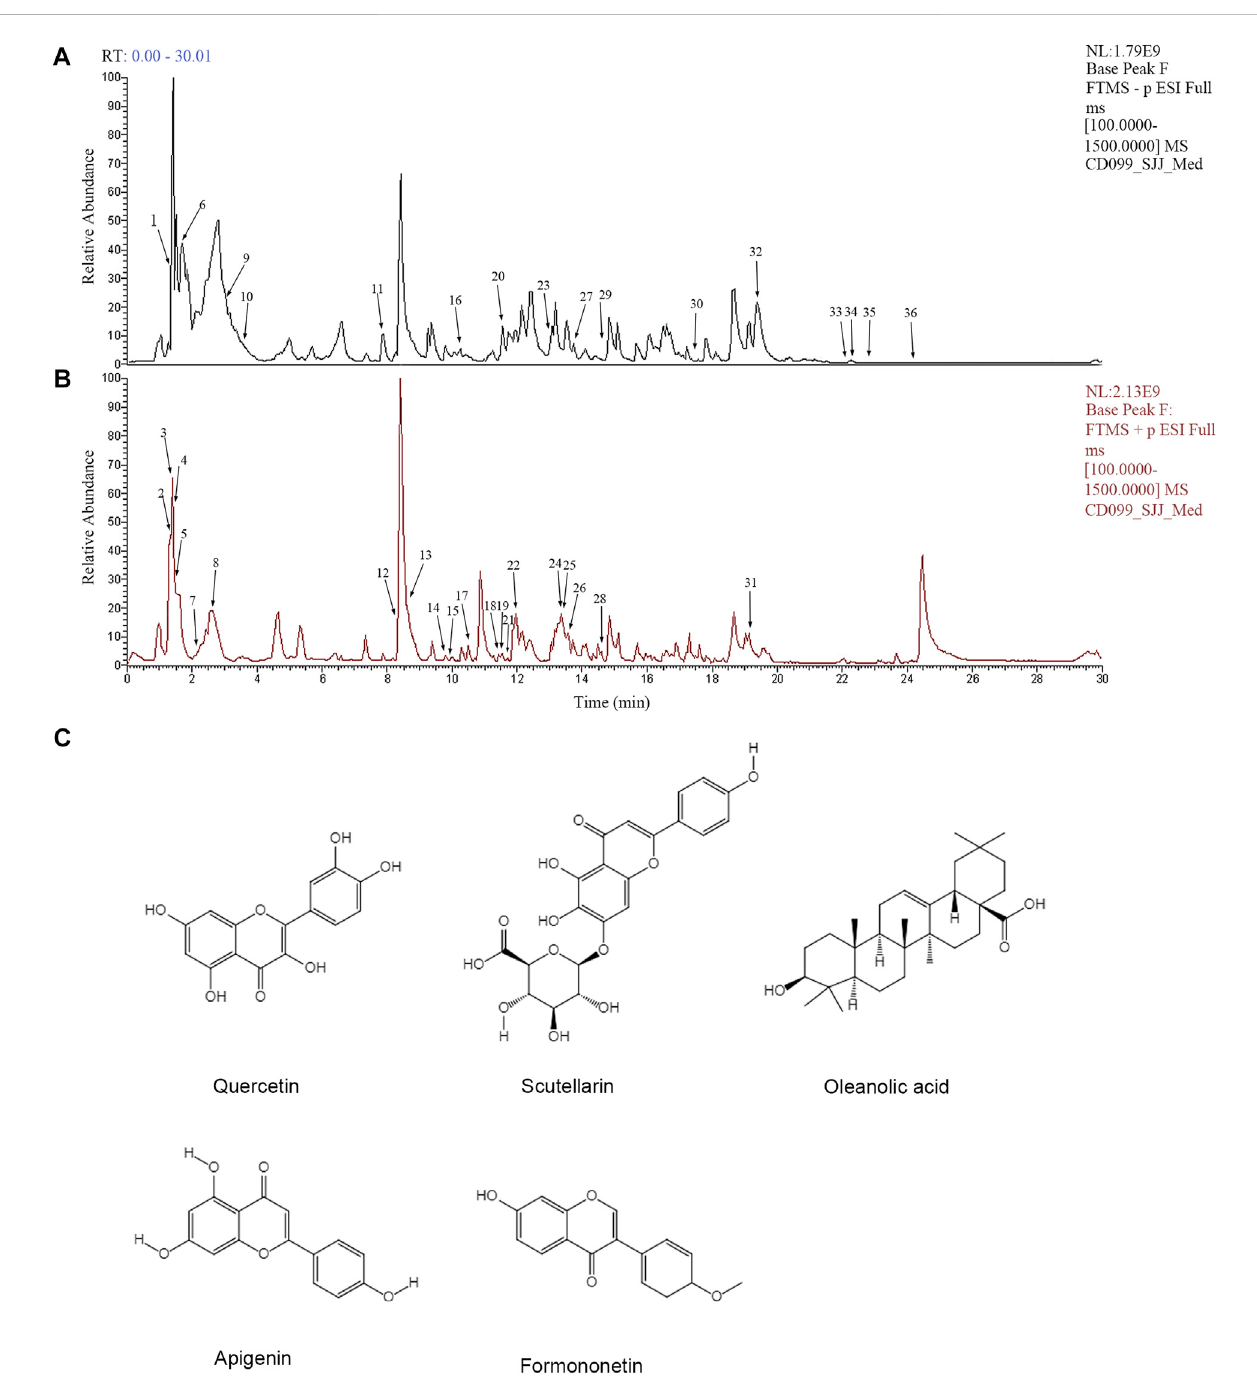
FIGURE 1 Analysis of the main chemical components of Feiyiliu Mixture (FYLM) by UPLC-Q-Orbitrap-MS in (A) negative ion mode and (B) positive ion mode. (C) Typical chemical structure formulas of